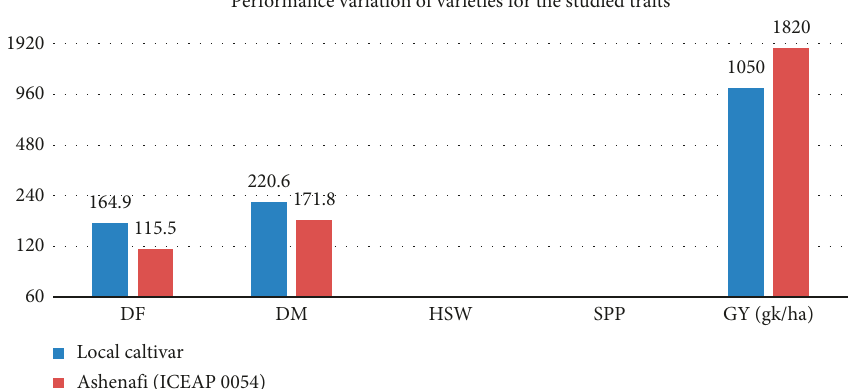
Figure 2: Comparison of important traits of pigeon pea varieties. DF, days to 75% flowering; DM, days to 90% maturity, HSW (gm), hundred seed weight; SPP, number of seeds per pod; GY (kg ha − 1 ), grain yield measured in